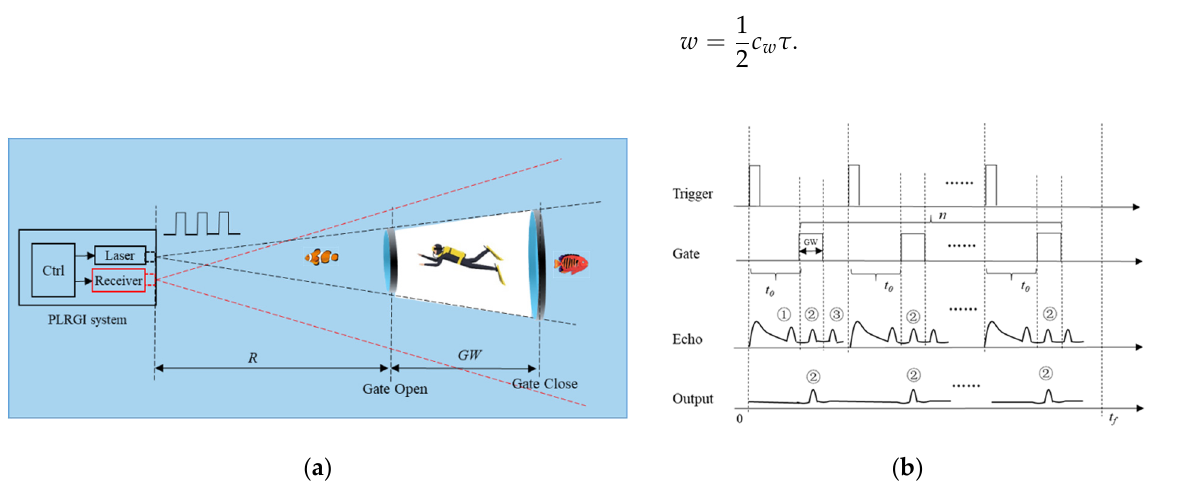
( b ) Figure 2. Description and Time sequence of the single slice. ( a ) Principle of PLRGI; ( b ) Time se- quence of the single slice. PLRGI system enables a slice imaging approach similar to that of computed tomog-